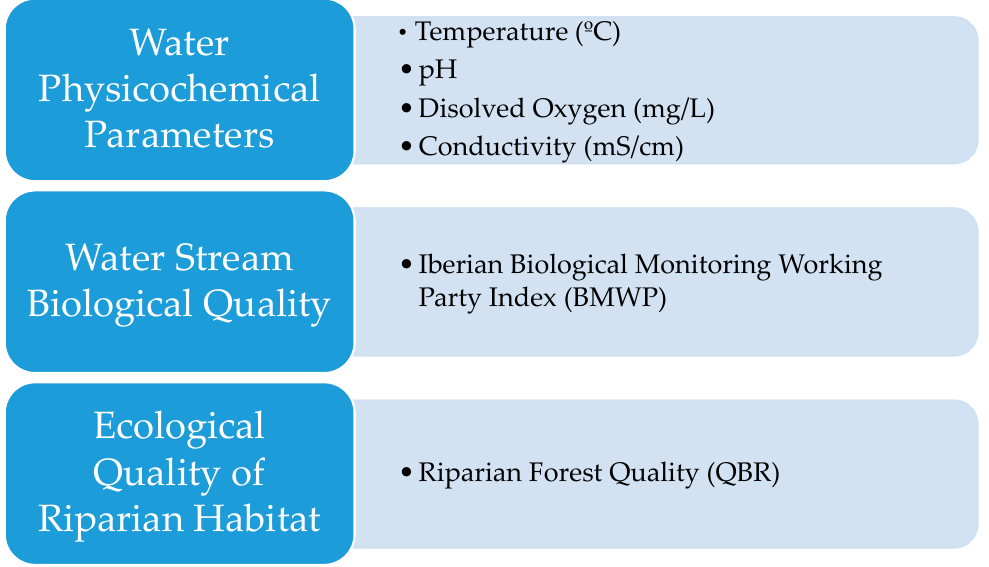
Figure 2. Schematic overview of the methodology.